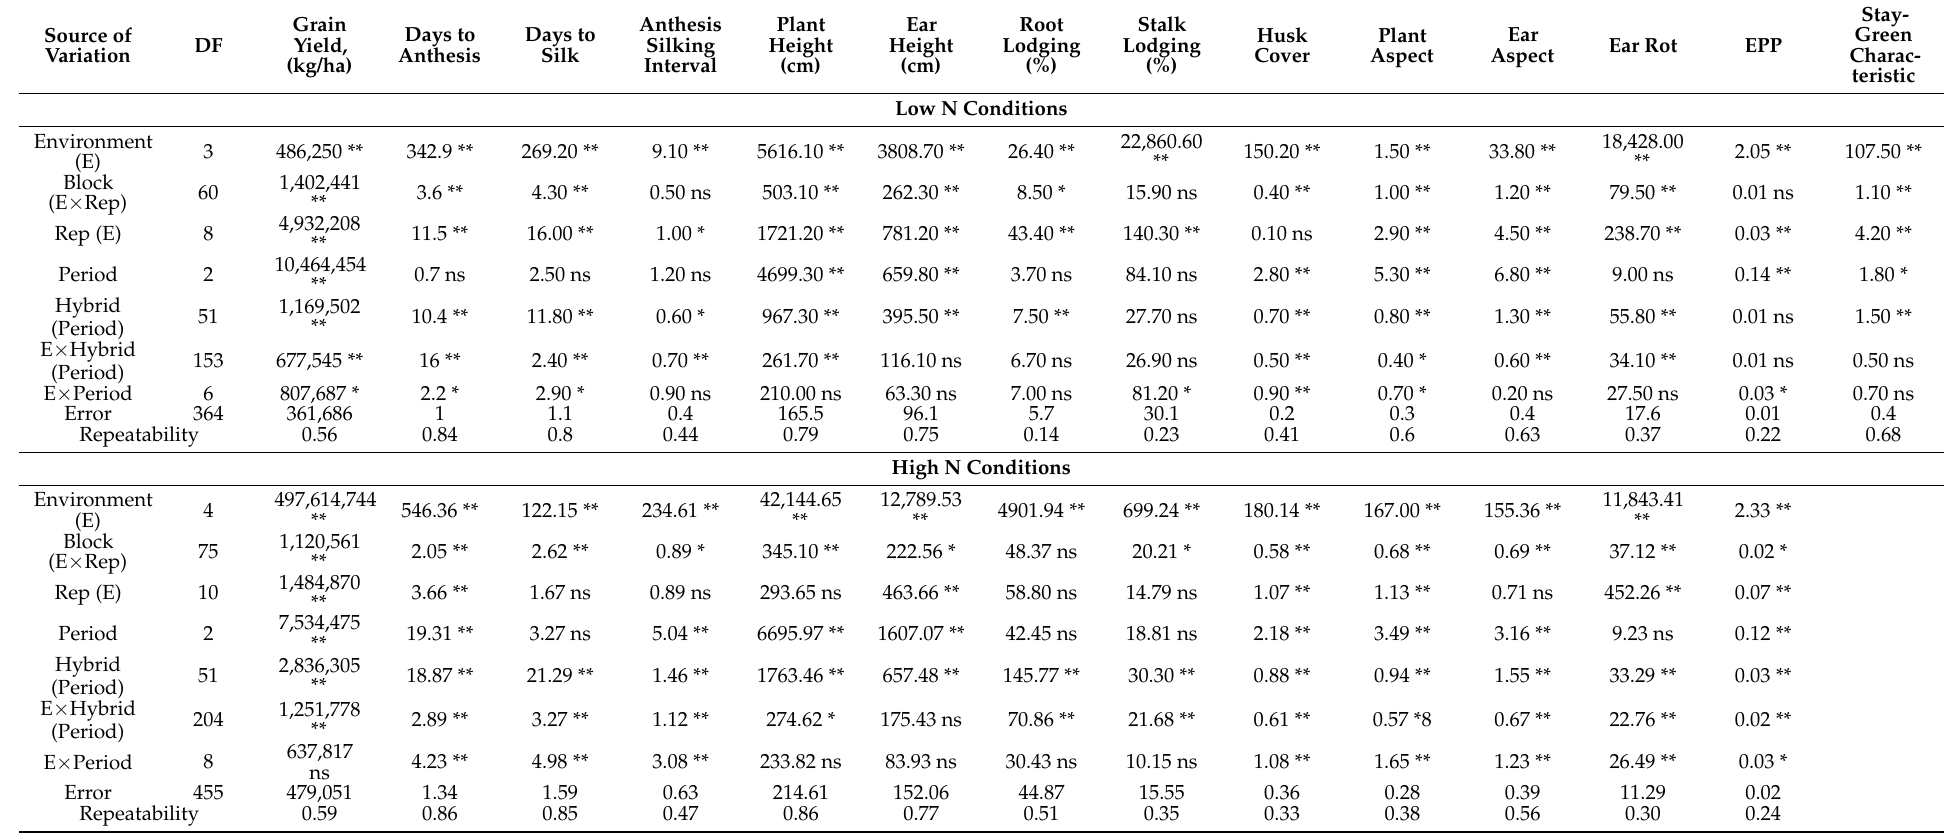
Table 1. Mean squares of grain yield and other agronomic traits of early maize hybrids of three breeding periods under low N conditions across four environments and high N conditions in five environments in Nigeria from 2017 to